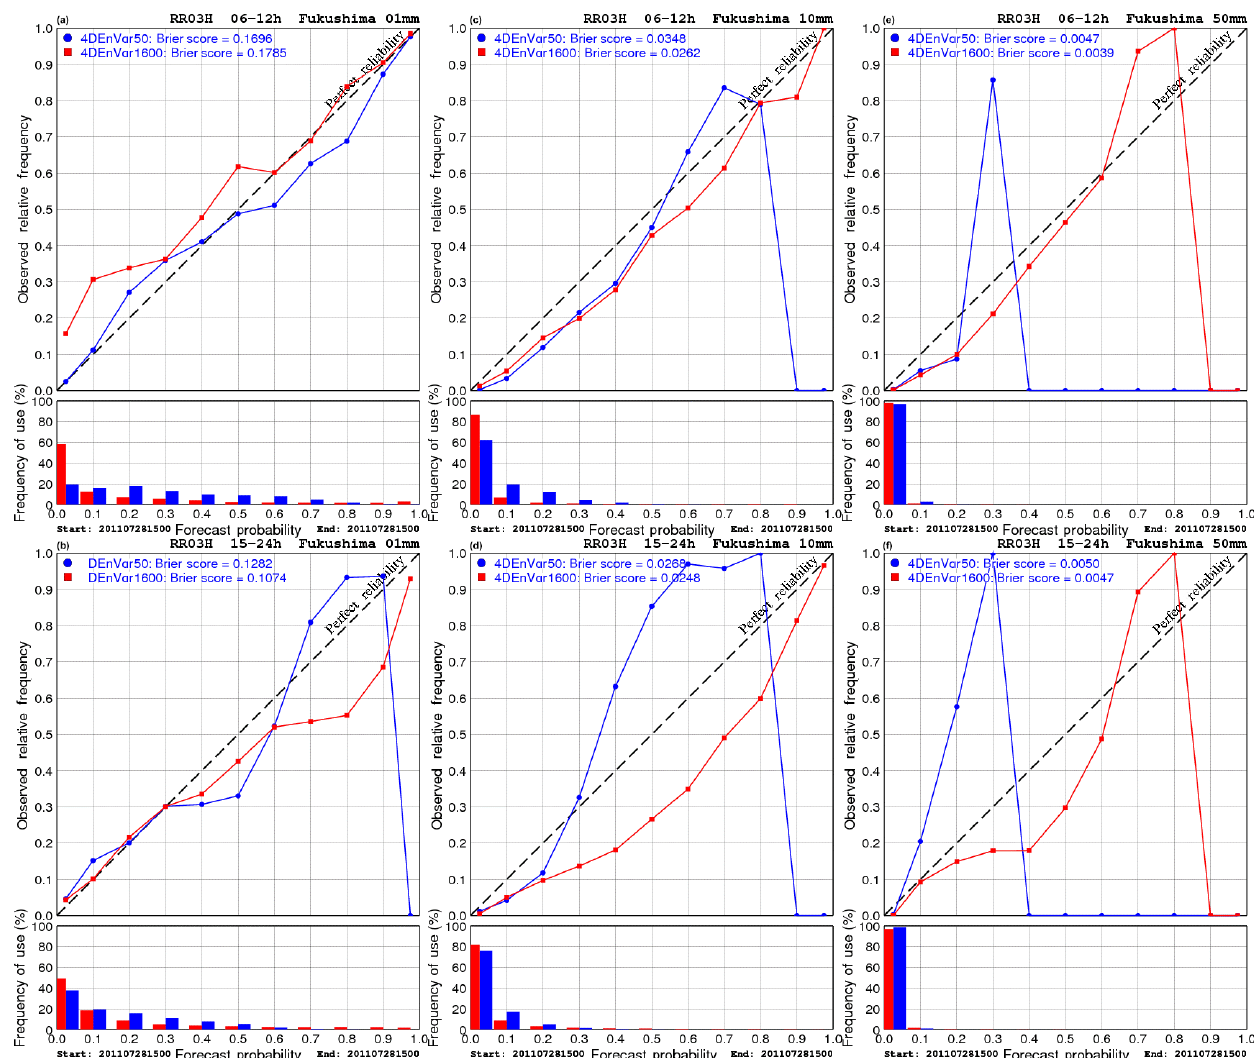
Figure 2. As in Fig. 1 but for reliability diagrams of 3h precipitation from ensemble forecasts initialized by analysis ensembles of 4D-EnVar- NHM using 1600 and 50 members. Three precipitation thresholds of 1mm (a, b) , 10mm (c, d) and 50mm (e, f) are chosen. Note that the ensemble forecasts were only run for the time 00:00JST on 29 July